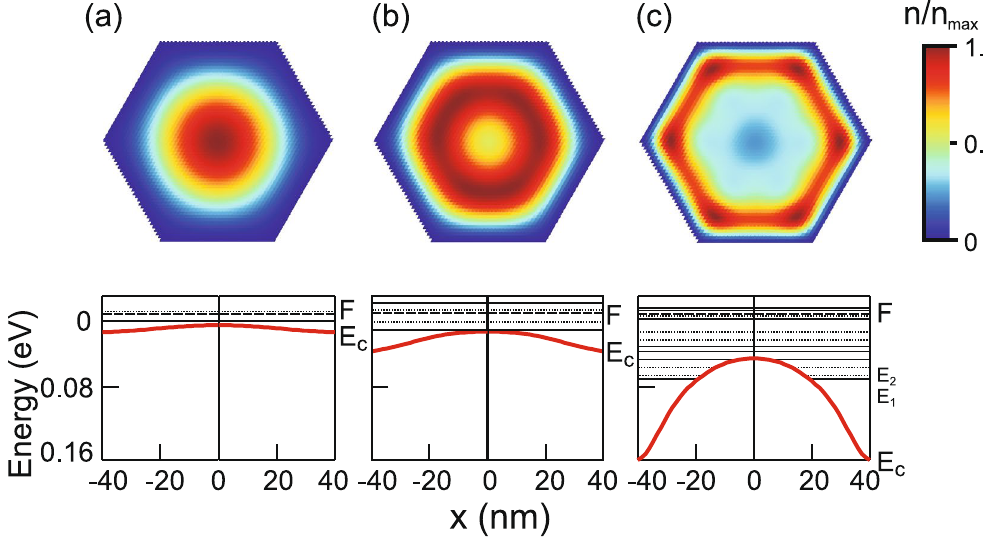
Figure 2. Upper: Two-dimensional electron distribution in a nanowire with a side length of 40 nm and the Fermi level positioned 0.02 ( a ), 0.04 ( b ), and 0.16 eV ( c ) above the conduction band edge at the surface ( T = 4 K). Lower: The conduction band diagram and the eigen energy states (non-degenerate (solid line) and doubly degenerate (dashed line)) in the nanowire for the values of ( F − E c ) indicated